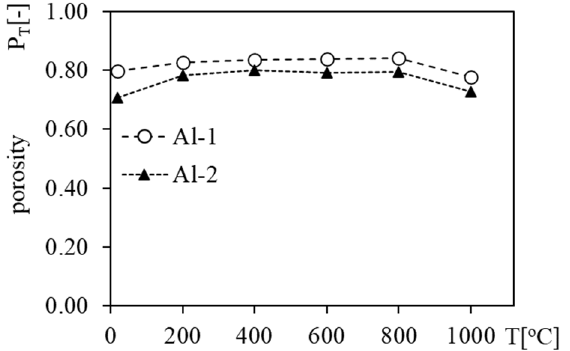
Figure 6. Porosity P of heated geopolymer foams Al-1 and Al-2 in the function of temperature.